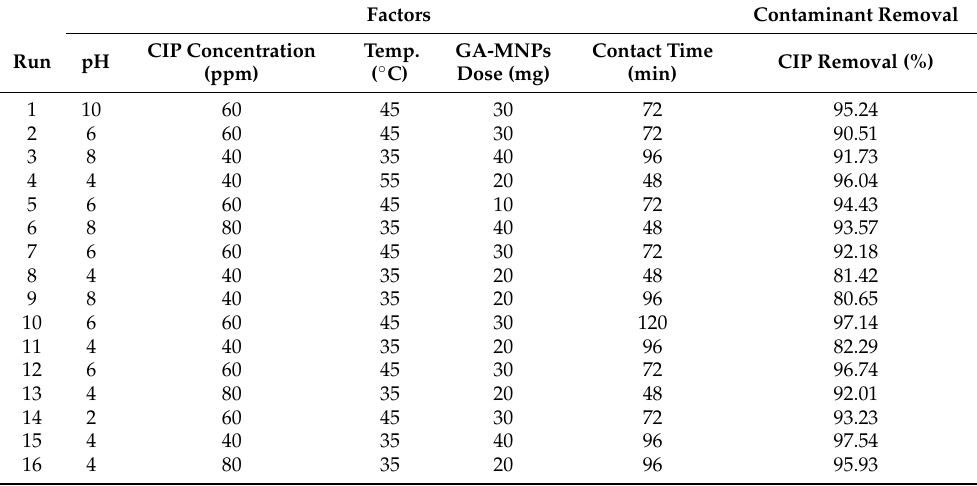
Table 3. Design matrix for CIP removal.